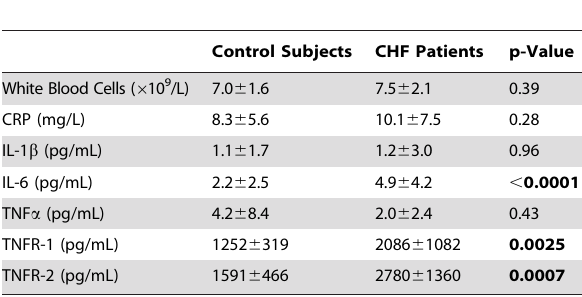
Table 2. Baseline marker of immune activation and cytokines.